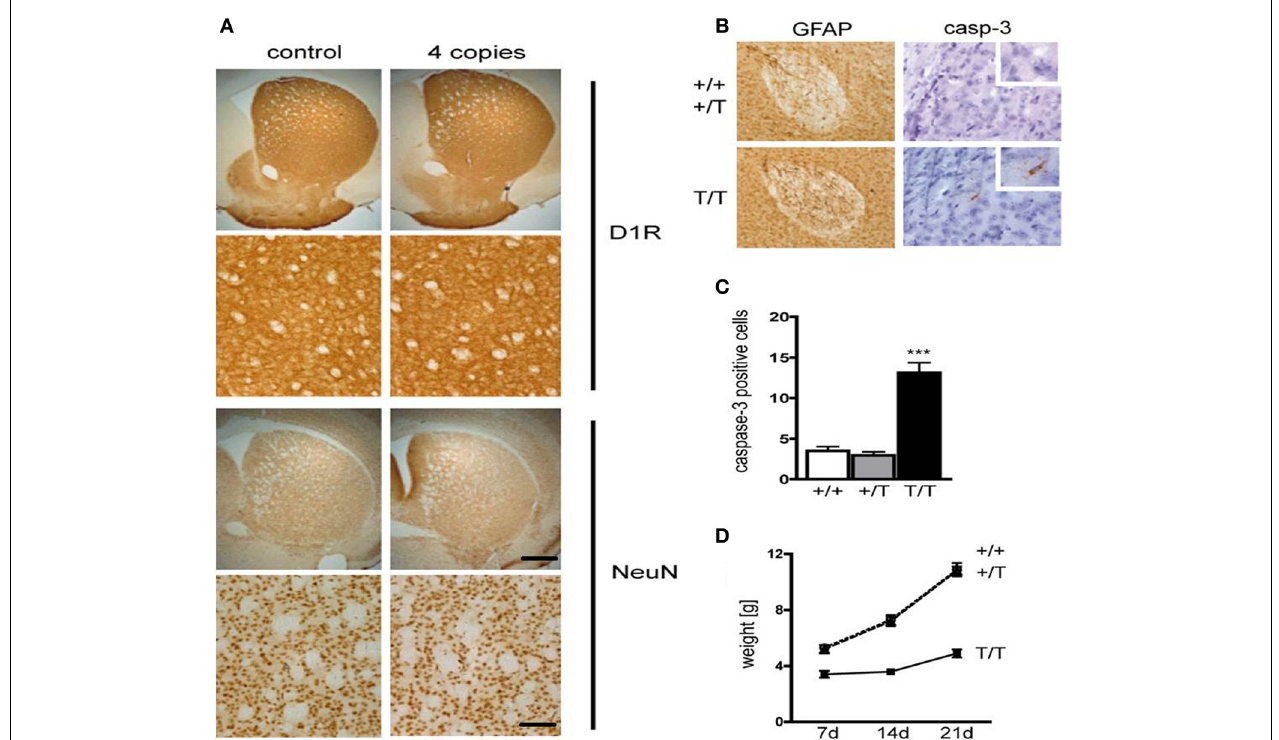
FIGURE 2 | Expression of D1-A-CREB transgene causes no significant increase in apoptosis or cell loss. (A) Immunohistochemical staining of coronal sections with antibodies against the dopamine receptor D1 (D1R) and the neuronal marker NeuN revealed no loss of cells or decrease in D1R abundance. (B) In contrast, D1-A-CREB mice carrying two transgenes (T/T) show an increase of GFAP (brown) and cleaved caspase-3 staining in